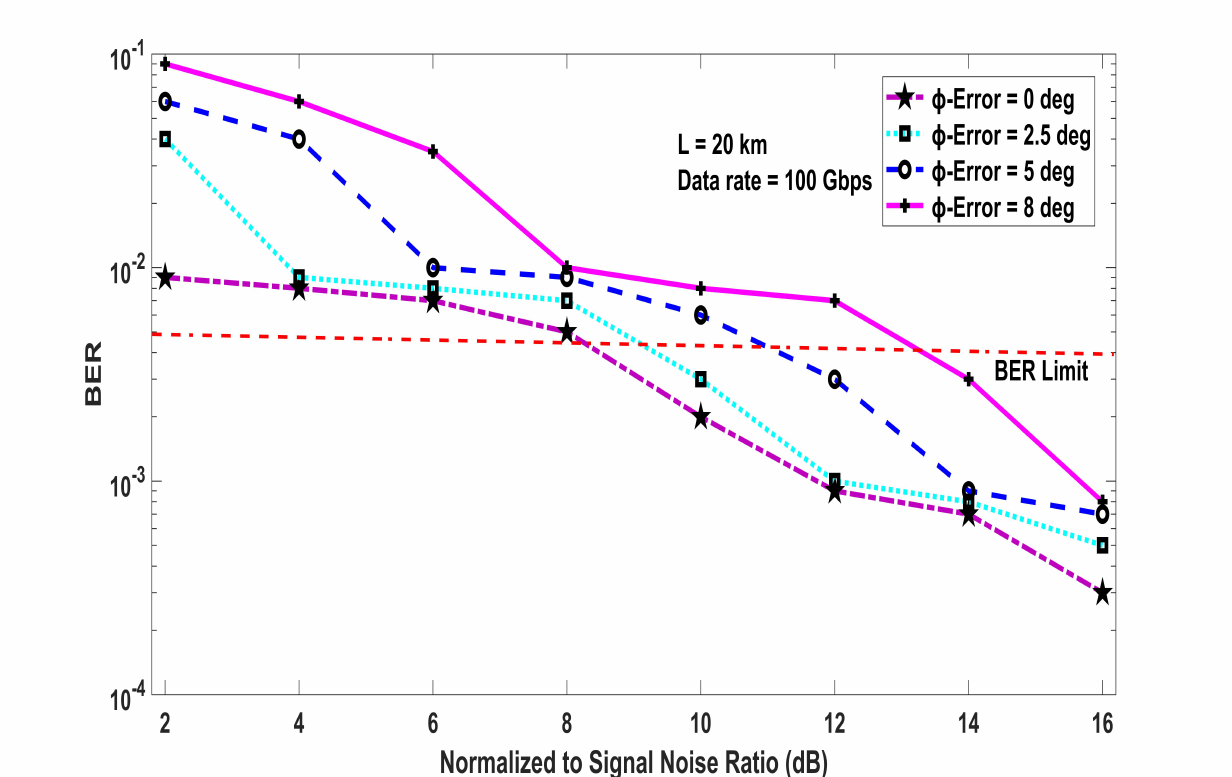
Figure 8. Outcomes of 0, 2.5, 5, and 8 deg phase noise based on the normalized signal-to-noise ratio and the BER.